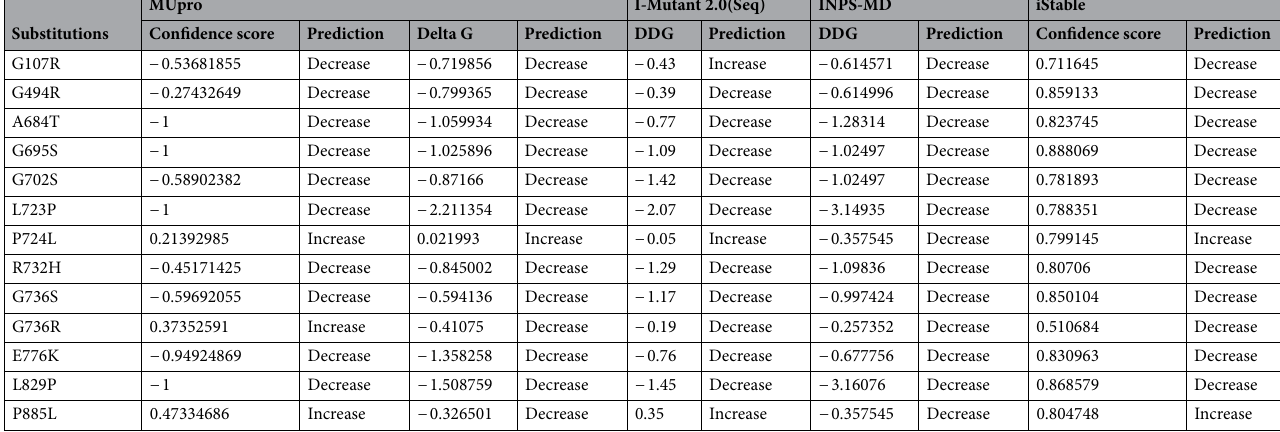
Table 2. Validation result of protein stability change by using MUpro, I-Mutant 2.0(Seq), INPS-MD and